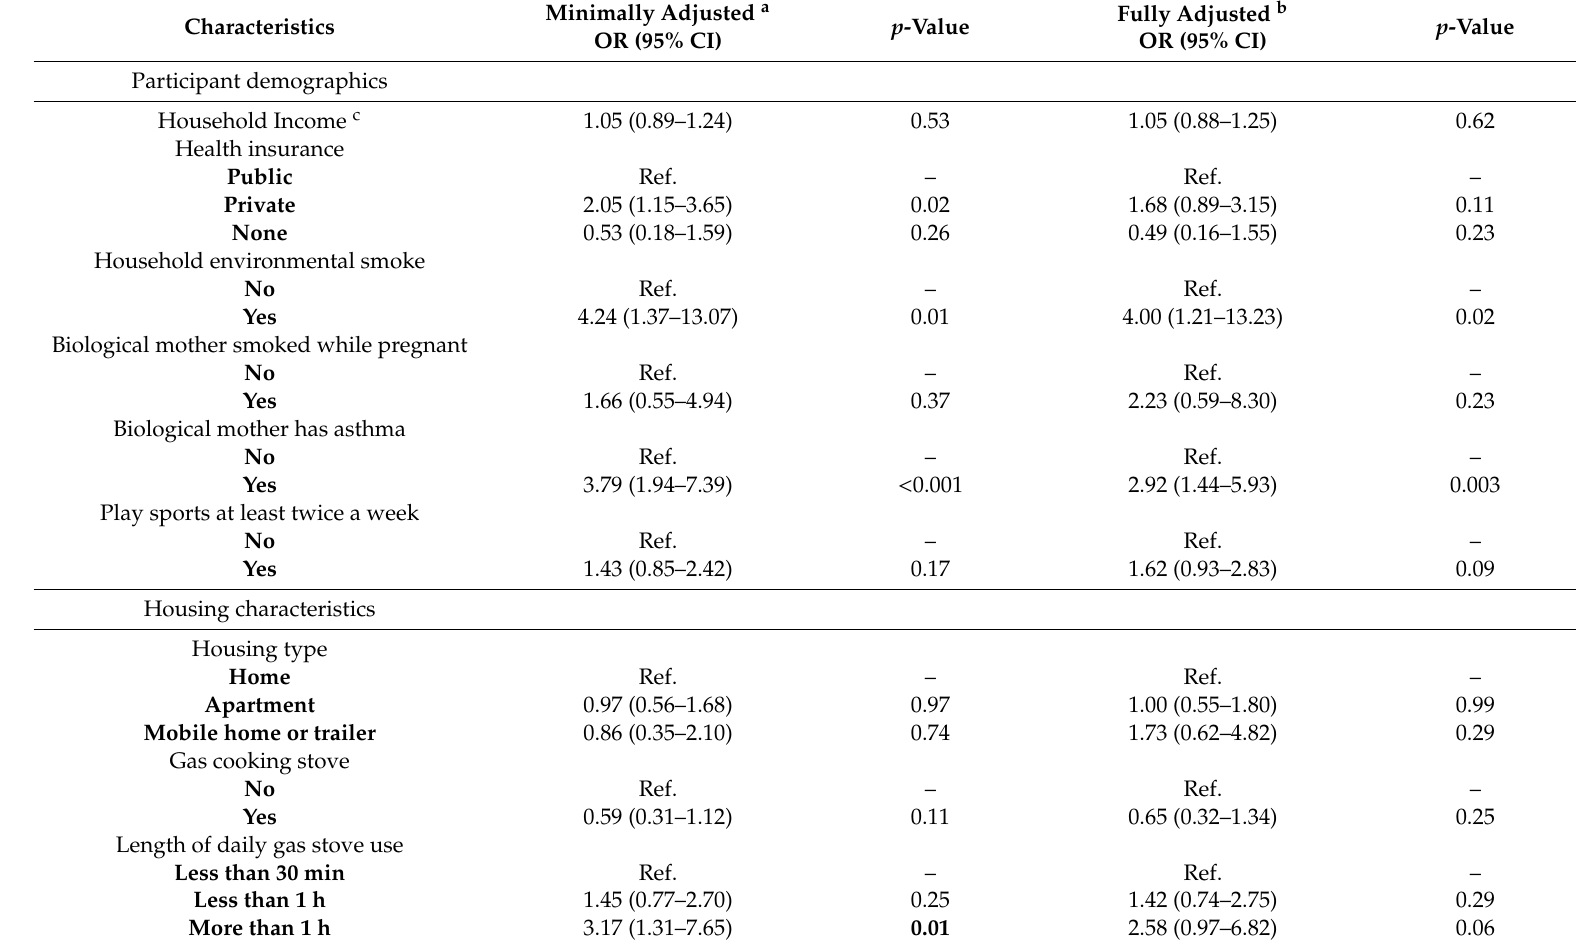
Table 3. Associations between individual demographic and household risk factors and the prevalence of